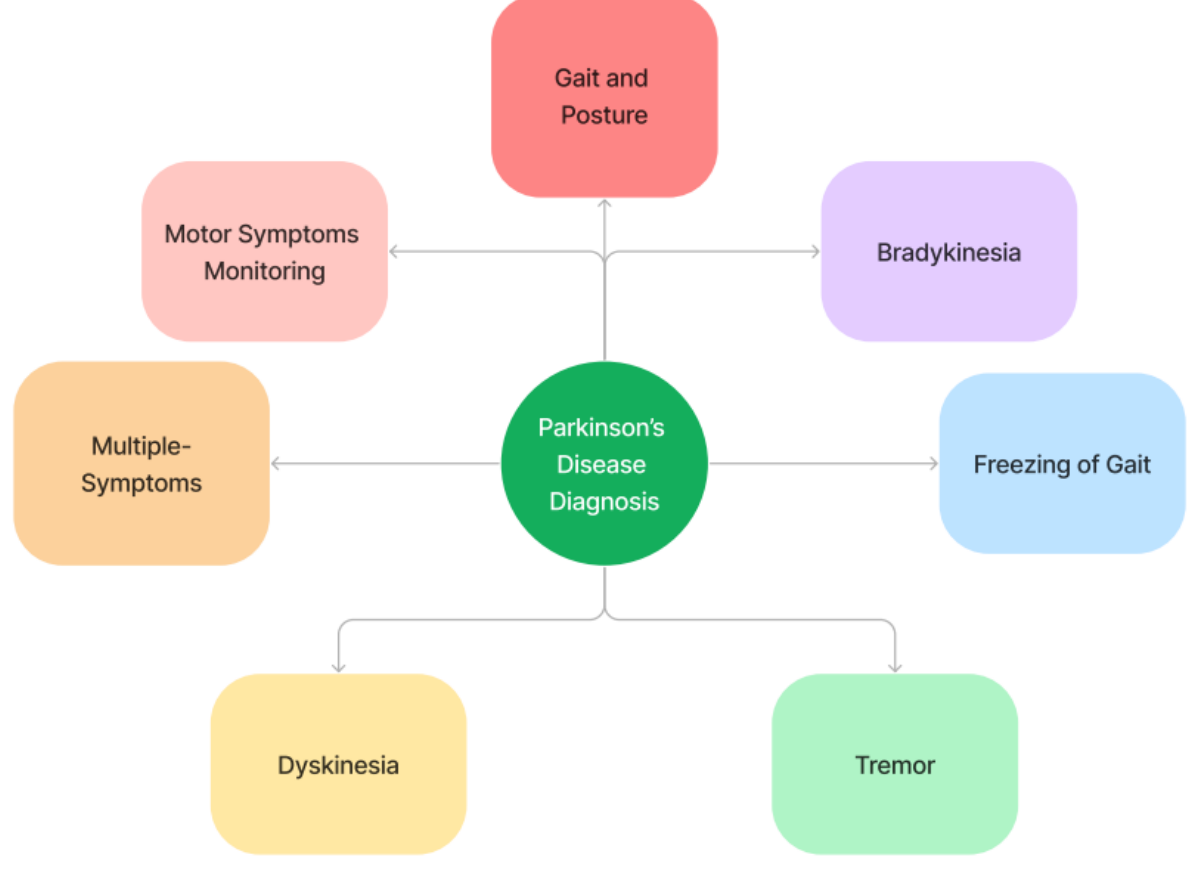
Figure 4. Parkinson’s disease diagnosis — overview .